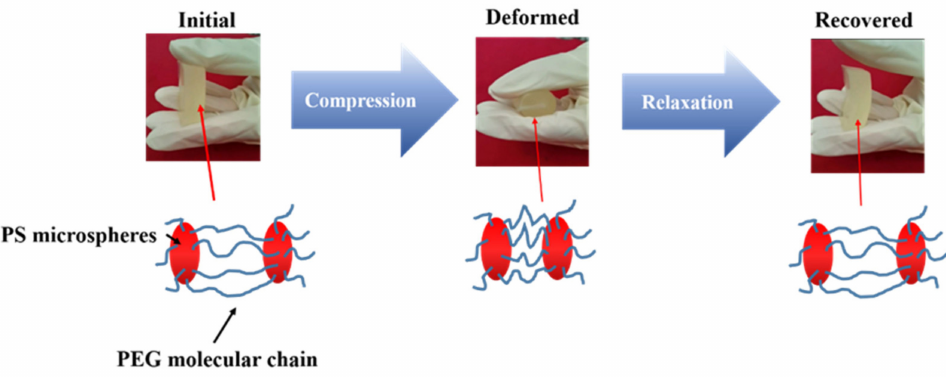
Figure 13. Schematic diagram of compression deformation and recovery of PS-PEG